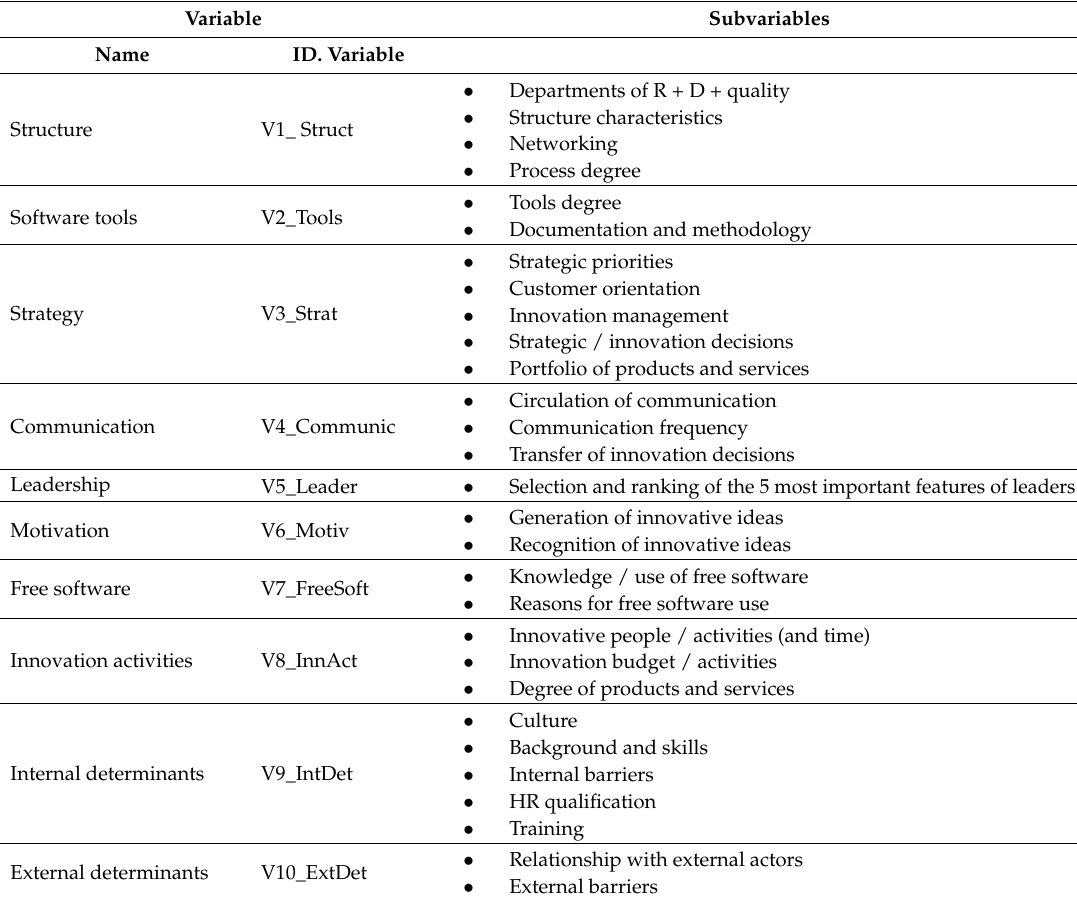
Table 2. Capabilities variables and